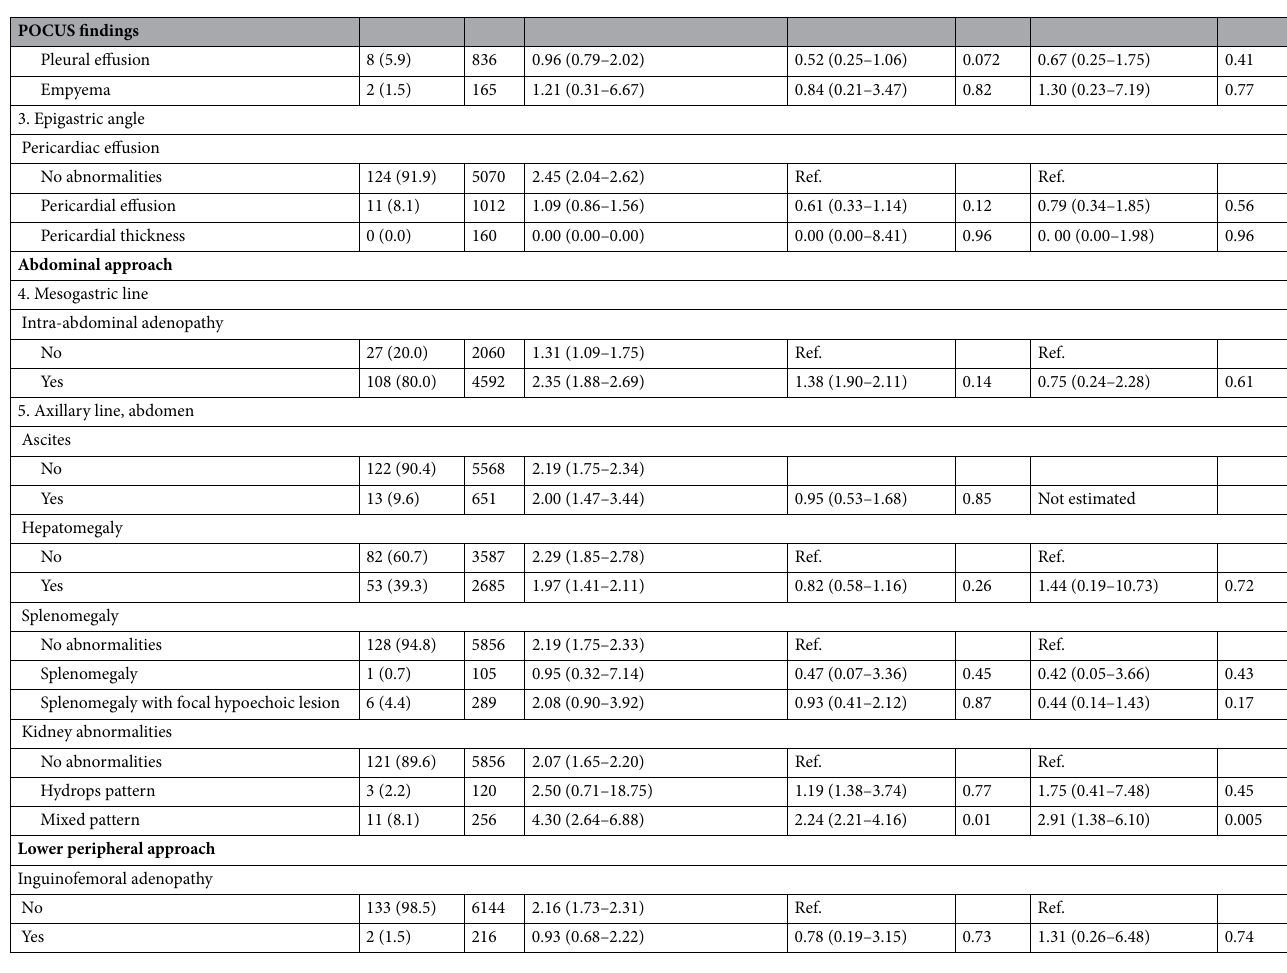
Table 3. Cox proportional hazards model for mortality in 390 in-patients with extrapulmonary tuberculosis, Carmelo Hospital of Chókwè (Mozambique), 2016–2020. PDH person-days of hospitalization, ART antiretroviral treatment, HR hazard ratio, CI confidence